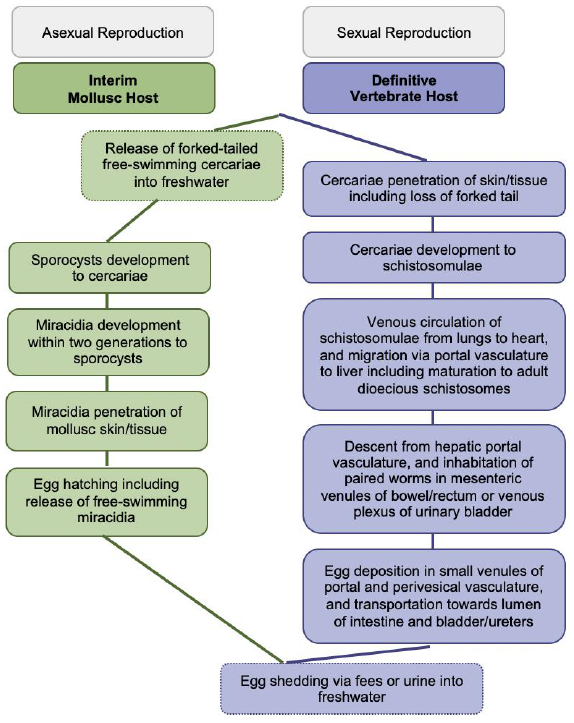
Figure 1. Generic Schistosoma life cycle.